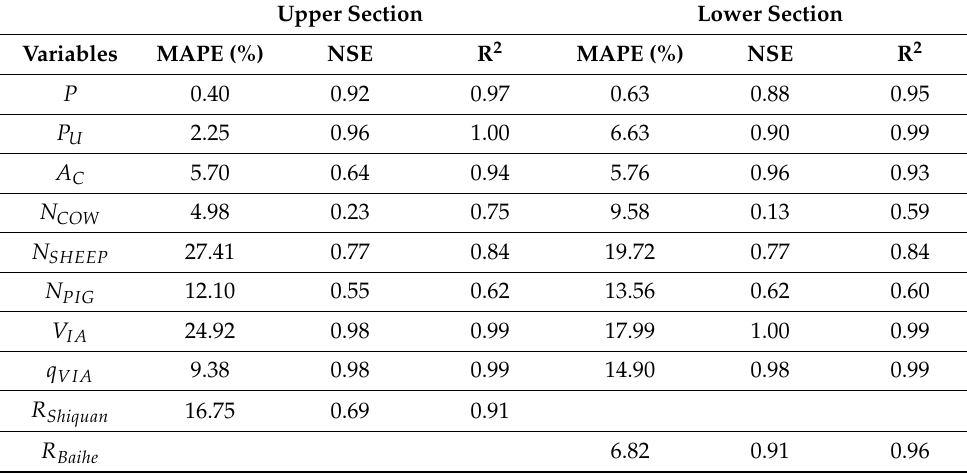
Table 4. The evaluation results in the calibration period (1990–2009).